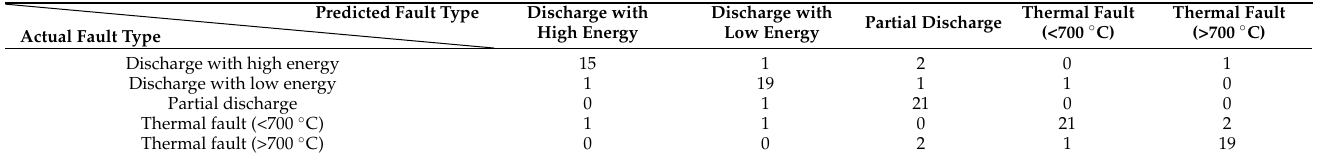
Table 7. Confusion matrix of GBCT.